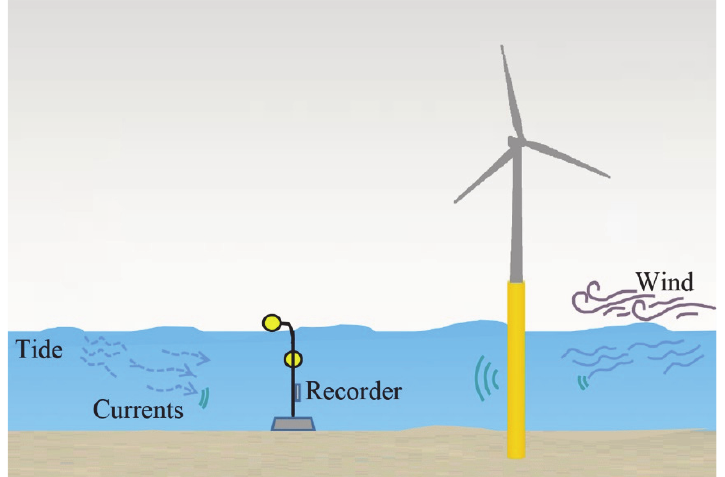
Figure 1. Measurement of operational signals from offshore wind turbines is disturbed by heavy underwater ambient noise.